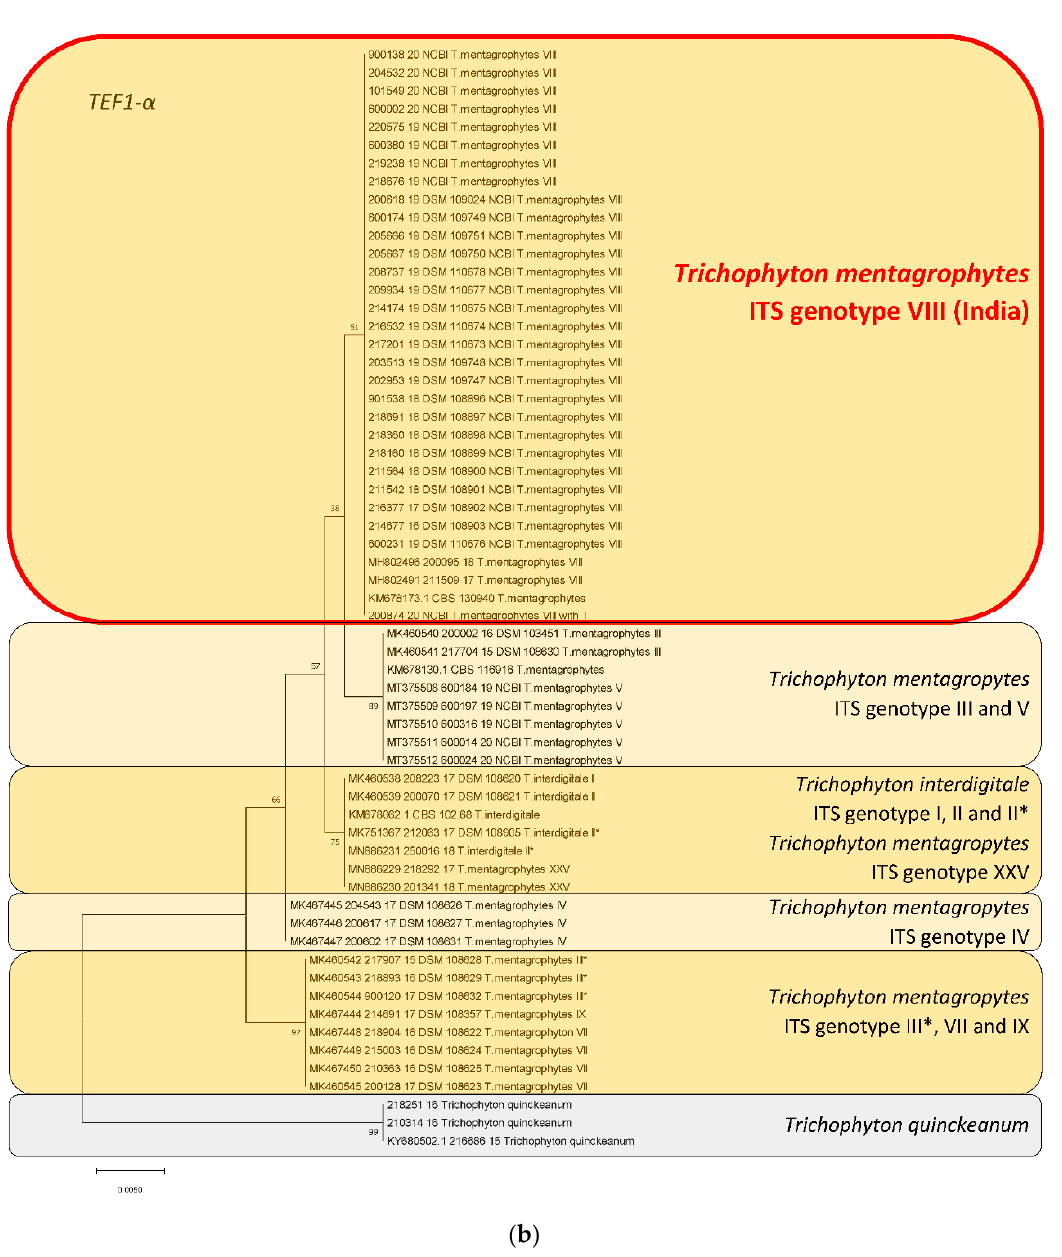
( T . mentagrophytes Type VIII or clade) were clearly discriminated from already known T .